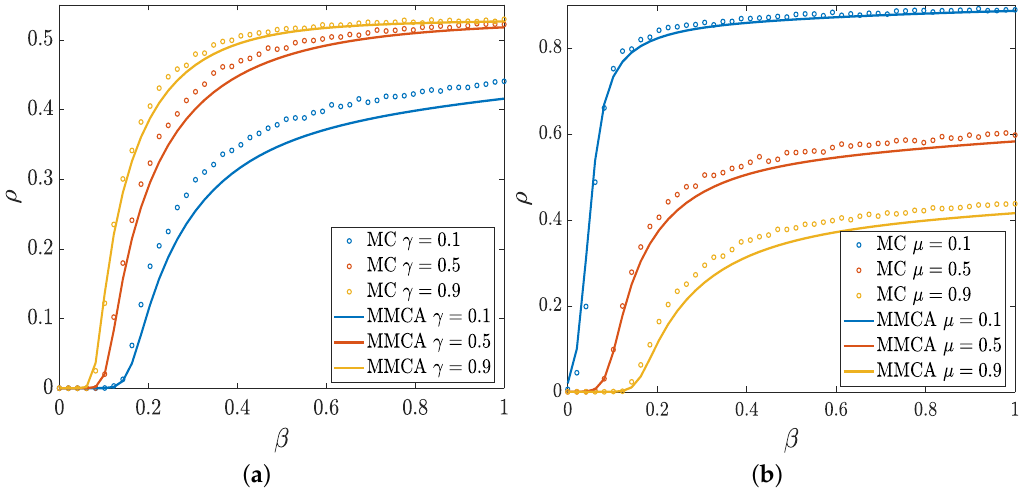
Figure 3. The infection density ρ as a function of the infectivity parameter β for different values of γ ( a ) and different values of µ ( b ). The result of ( a ) is obtained for µ = 0.9 and that of ( b ) is for γ = 0.1. And the other parameter values are set to λ 1 = η = 0.9, λ 2 = τ = δ = 0.5, ι = 1.1, ¯ x = ¯ y = 3.